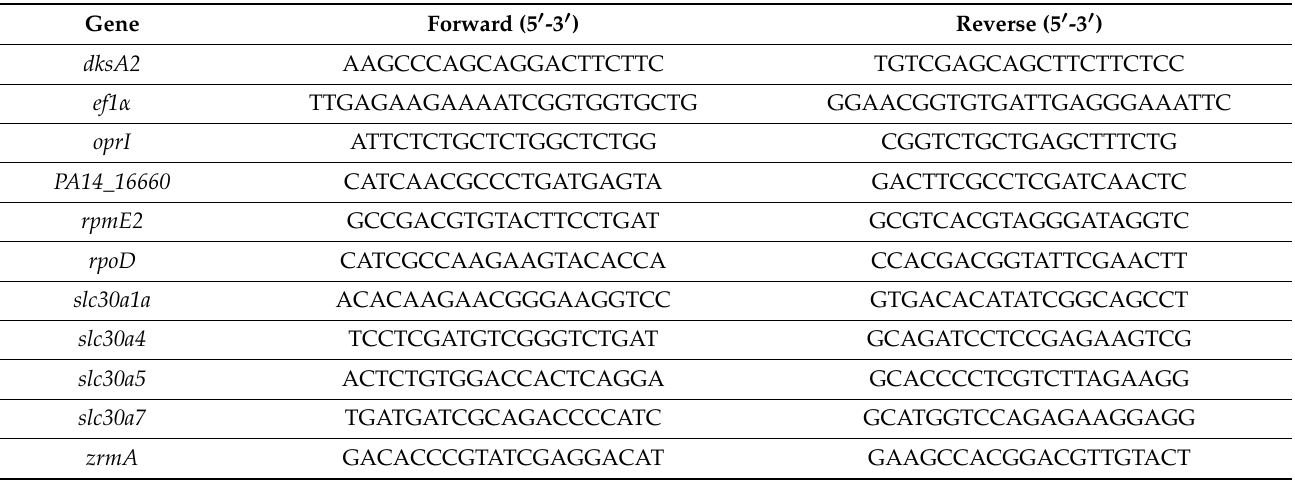
Table 2. Primers used for